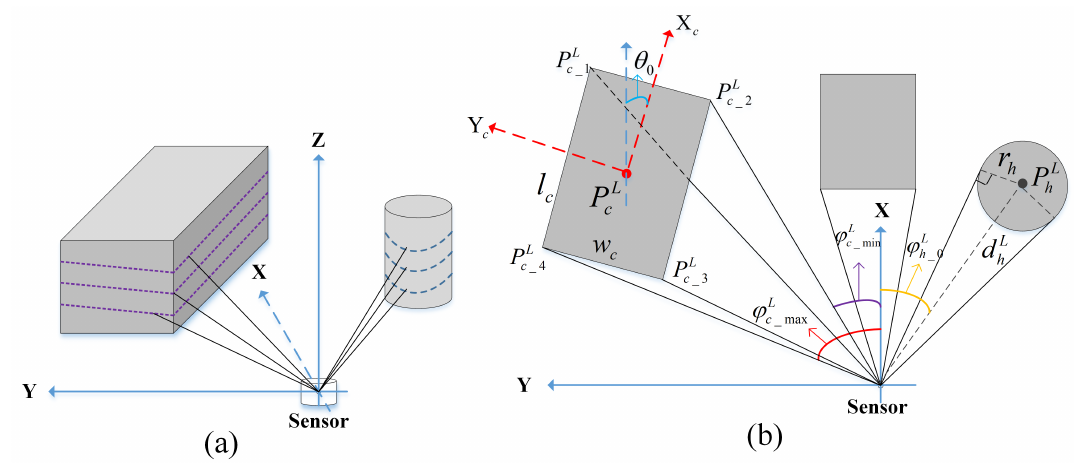
Figure 2. The geometric models used for dynamic objects simulation, cuboids and cylinder, are scanned by LiDAR ( a ). ( x o , y o ) in the sensor coordinate frame, the LiDAR measurements can be According to their poses P L c ( x o , y o , θ o ) and P L h simulated respectively ( b ), which is calculated in XY plane of the sensor frame. We denote the world coordinate frame as W , the sensor coordinate frame as L , and the robot body frame as B . Depending on the position and shape of the object, one or two sides of the object can be detected. By evaluating the boundary of the models in sensor’s FOV the echo data can be